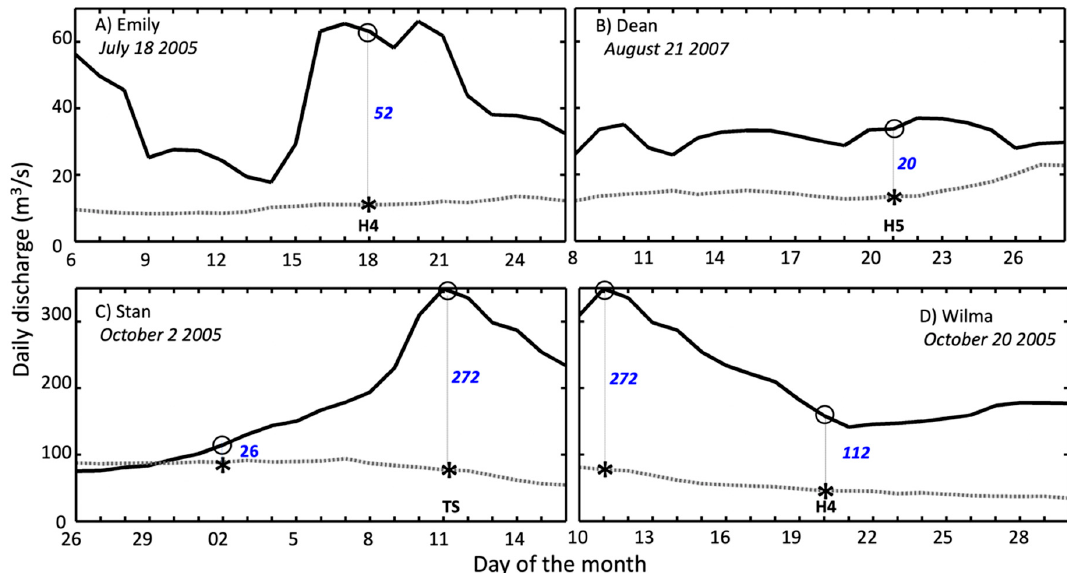
Figure 8. Daily discharge (m 3 / s) (dark line) and long-term average (dotted gray line) at the Canasayab, Champoton River gauge station during the passage of tropical cyclones Emily ( A ), Dean ( B ), Stan ( C ), and Wilma ( D ). The long-term average was computed from daily observations in the period from 1956–2014. The asterisk and dot symbols mark values at landfall; in blue is the net difference between the discharge value and the long-term average. Panels C and D show two net values due to the asynchrony between landfall time and the discharge response. The river catchment area is 2583 km 2 while the gauge station drainage area is 2330 km 2 .